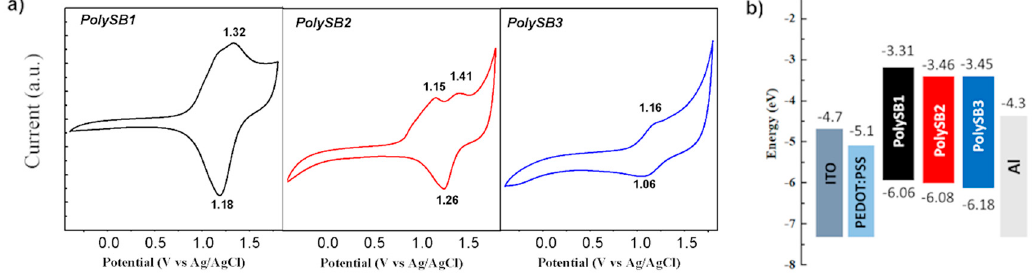
Figure 6. Cyclic voltammograms of polySBs in 0.1 M Bu 4 NPF 6 in dichloromethane, at a scan rate of 100 mV s − 1 ( a ) and energy levels ( b ).